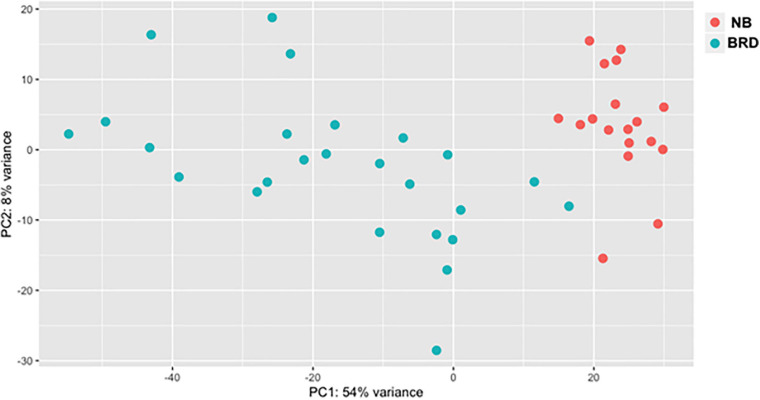
Principal component analysis (PCA) plot comparing differences in total differentially expressed (DE) gene populations between bovine respiratory disease (BRD) and non-BRD (NB) animals. PCA plot displaying differing clustering patterns between heifers displaying clinical signs of BRD (blue) and non-BRD animals (red). Plot was designed using normalized counts (n = 43), using the variable stabilization transformation for the PlotPCA tool in DEGSeq.